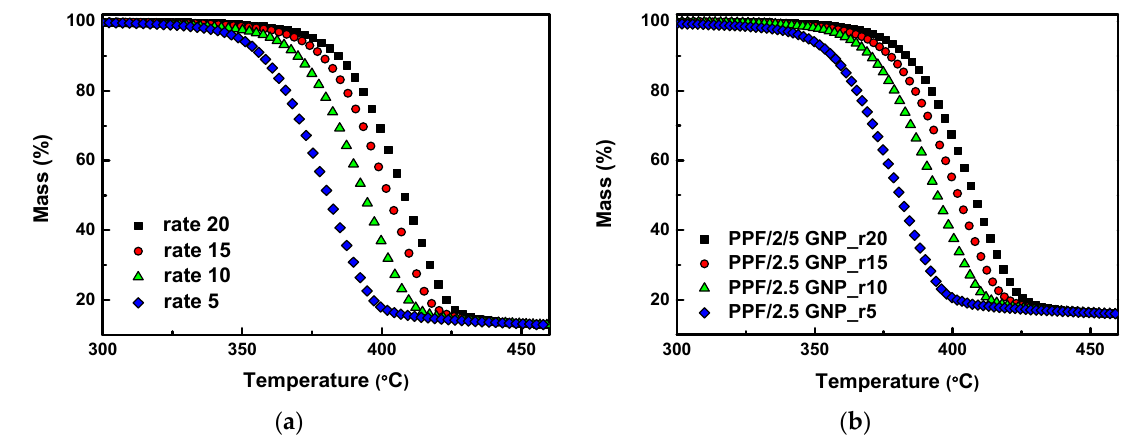
Figure 4. Mass (%) curves of ( a ) neat PPF; ( b ) PPF/2.5 GNP nanocomposite at heating rates of 5, 10, 15, and 20 °C/min under nitrogen.